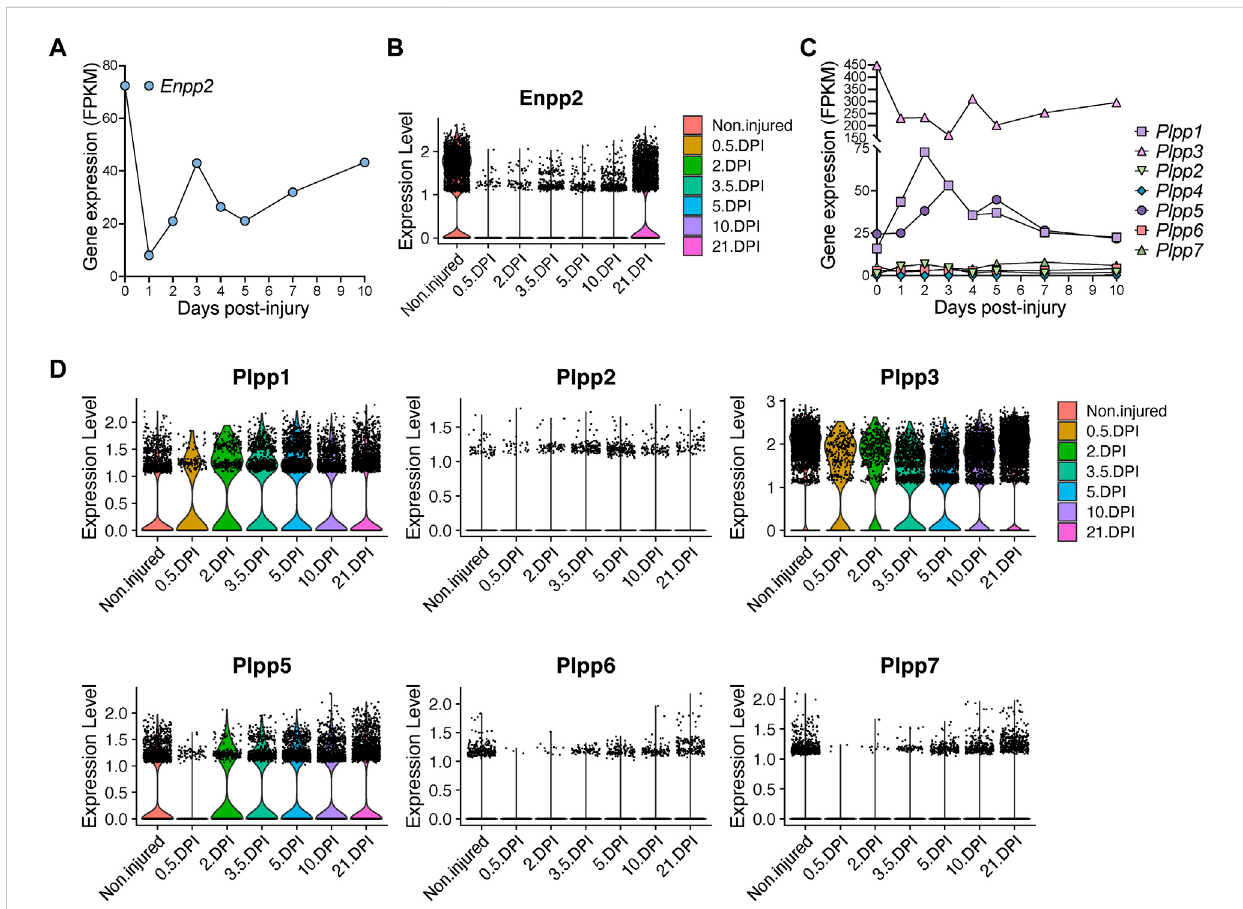
FIGURE 5 Quick and pronounced gene repression of LPA-producing and -catabolizing enzymes in fi bro-adipogenic progenitors following muscle damage. (A) Quanti fi cation of Enpp2 transcript abundance (FPKM) in Hic1 + tdTomato expressing cells in response to injury. (B) Violin plots showing the gene expression level of Enpp2 in FAPs in response to injury. DPI, Days post-injury. (C) Quanti fi cation of different Plpps transcript abundance (FPKM) in Hic1 + tdTomato expressing cells in response to injury. (D) Violin plots showing the expression level of the seven Plpp genes in FAPs in response to